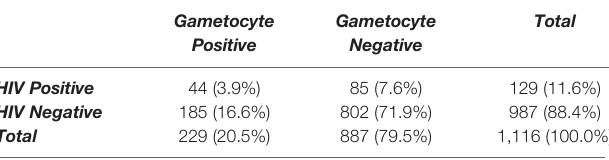
TABLE 1 | Comparison of gametocyte positivity, as measured by detectable transcripts for one or more gametocyte markers, by HIV-1 status. Gametocyte